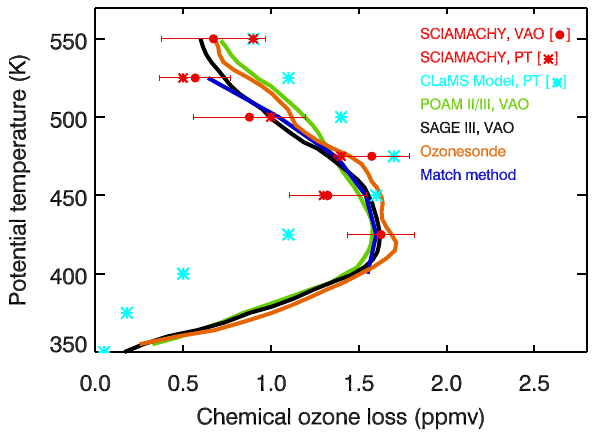
Fig. 13. Comparison of the vertical variation of the chemical ozone loss in the Arctic polar vortex for the time period 5 January–25 March 2005 estimated using various data sources and techniques. The red circles with error bars represent the accumulated ozone loss using a vortex averaged method from this study (denoted by VAO). The cyan asterisks represent the ozone loss derived by subtracting the simulated ozone from the passive ozone tracer (denoted by PT) for the selected SCIAMACHY vortex observation locations. The red asterisks depict passive tracer subtraction between SCIAMACHY observed data and the corresponding CLaMS passive ozone tracer. The POAM, SAGE, ozone sonde as well as the match technique data were taken from Rex et al. (2006).